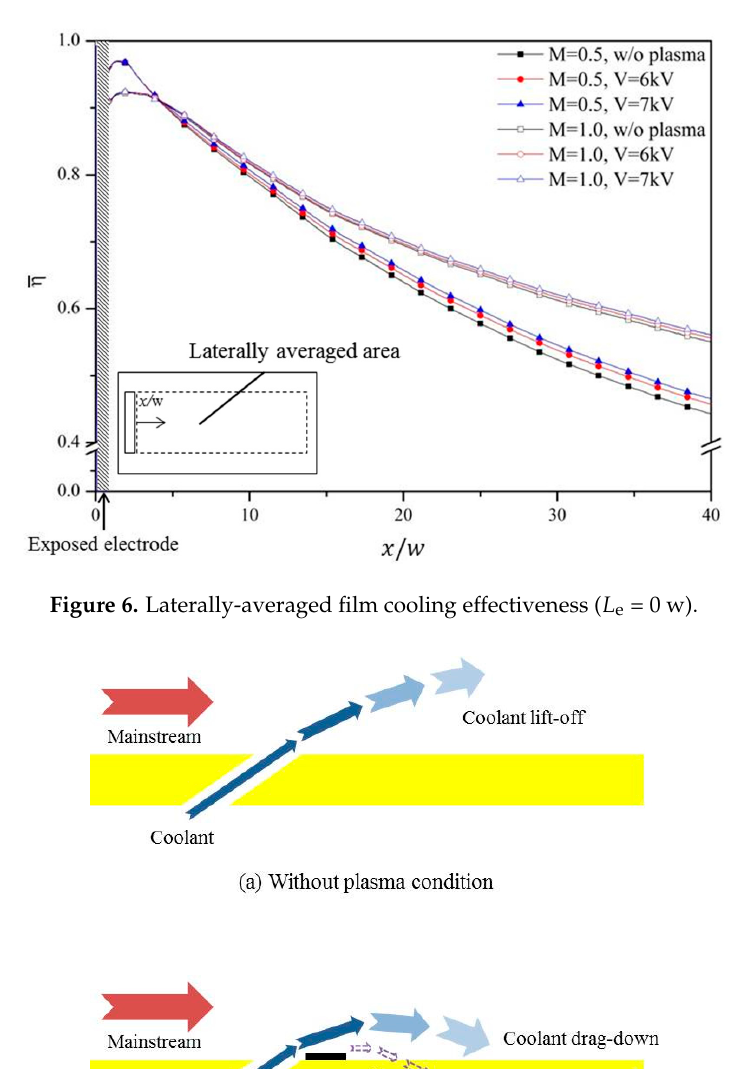
Figure 5. Distributions of film cooling effectiveness ( (cid:1838) (cid:2915) = 0 w).